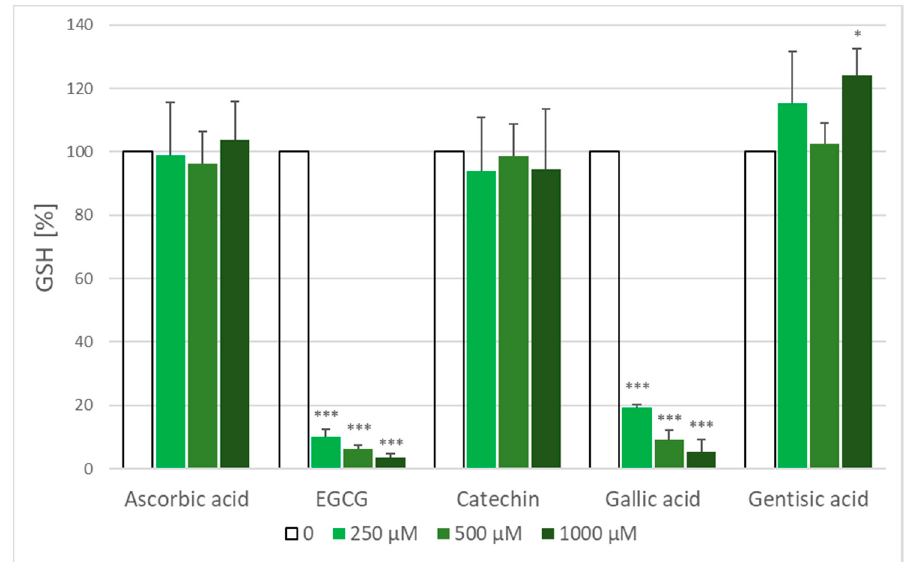
Figure 7. Effect of antioxidants on the GSH level in erythrocytes in the absence of AAPH. The level of GSH in control erythrocytes was assumed as 100%. * p < 0.05, *** p < 0.001 with respect to control.